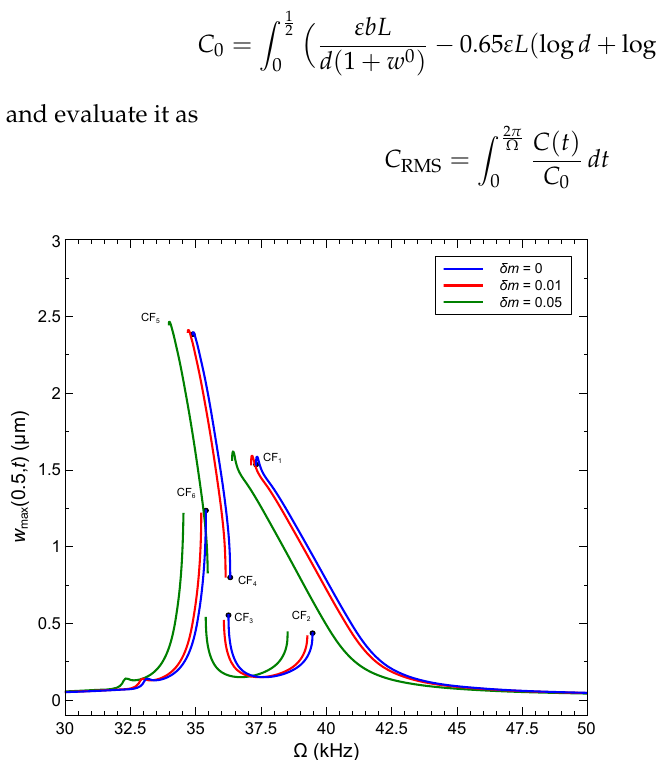
Figure 13. The frequency–response curves of bifurcation-based sensors based on arch microbeams with initial rise of w o = 6µm under the voltage waveform V DC = V AC = 12.2V. We show in Figure 14 the normalized RMS capacitance of an arch microbeam with an initial rise of w o = 6 µm under an excitation waveform of V DC = 12.2 = V AC = 12.2 V in the frequency range of [ 30 − 50 ] kHz as well as their counterpart once an added mass of δ m = 0.01 is introduced. Two sensors based on the CF 2 and CF 6 bifurcations are examined. The sensors operate in the gray shaded regions of the figure with their excitation frequencies set to Ω = ω CF2 and Ω = ω CF6 . The presence (or concentration) of the target gas results in the addition of a mass δ m = 0.01 and the sensor response jumping from the lower (blue colored) side of the bifurcation to the upper (red colored) side. The detection signal takes the form of an increase in the normalized RMS capacitance by